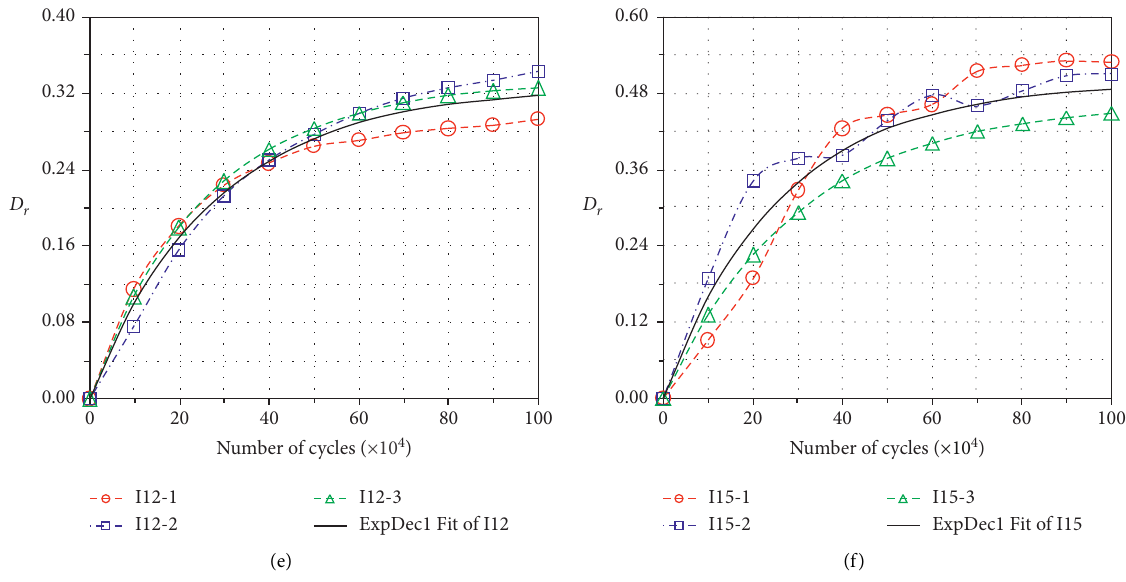
Figure 8: The damage evolution curves of initial damaged tunnel invert concretes subjected to high cyclic loading.